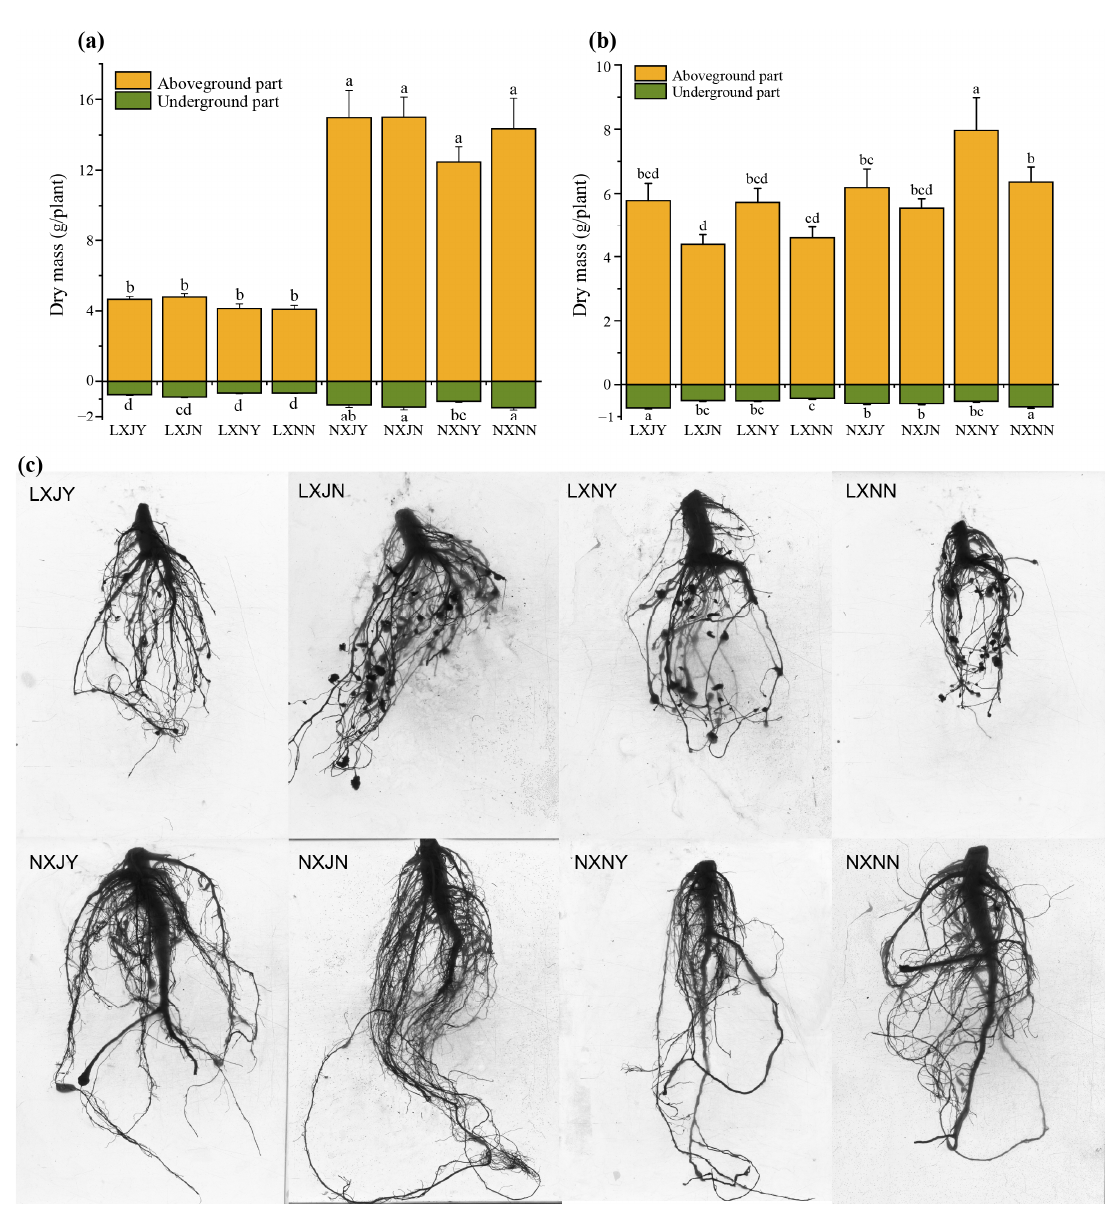
Figure 2. The D74 agent and maize rotation promote sunflower growth. Aboveground and underground dry weights of sunflowers at maturity in the first ( a ) and second ( b ) year. Scanning image ( c ) of sunflower roots at mature stage in second year. Different letters indicate significant differences between the groups (Tukey’s test, p < 0.05). Groups with O. cumana added: LXJY (maize rotation + D74); LXJN (D74 only); LXNY (maize rotation only); LXNN (sunflower planting only). Groups without O. cumana added: CKN (blank control); NXJY (maize rotation + D74); NXJN (D74 only); NXNY (maize rotation only); NXNN (sunflower planting only).